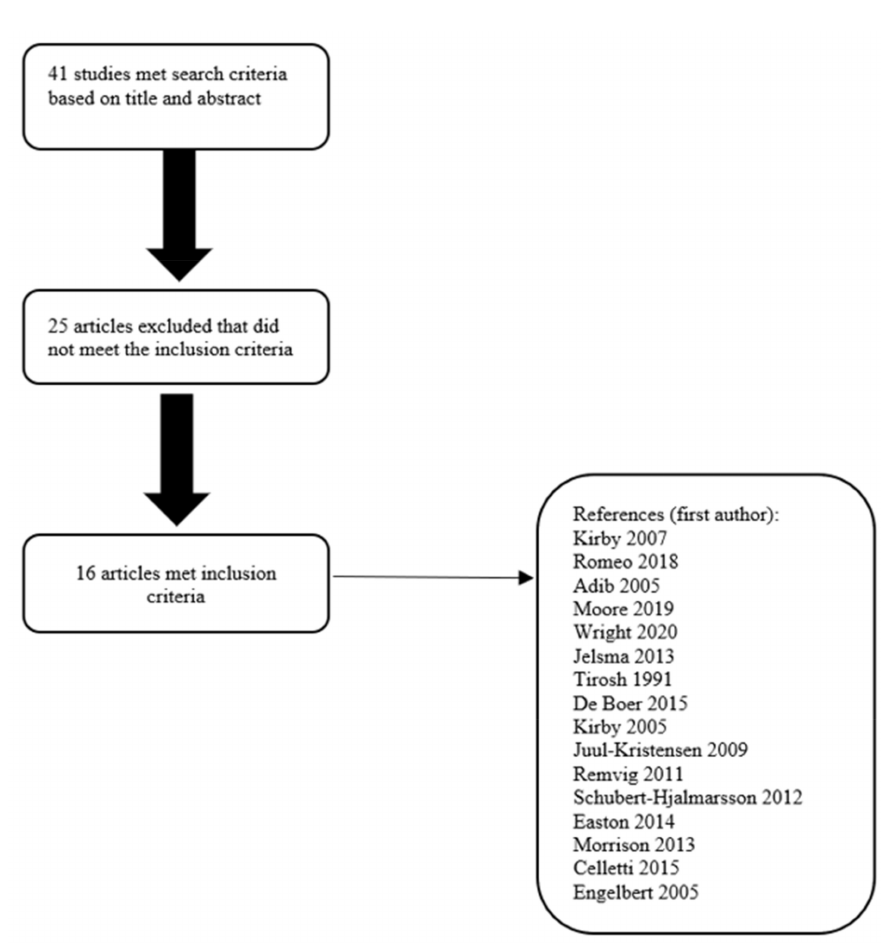
Figure 1. Flow chart for process of article inclusion